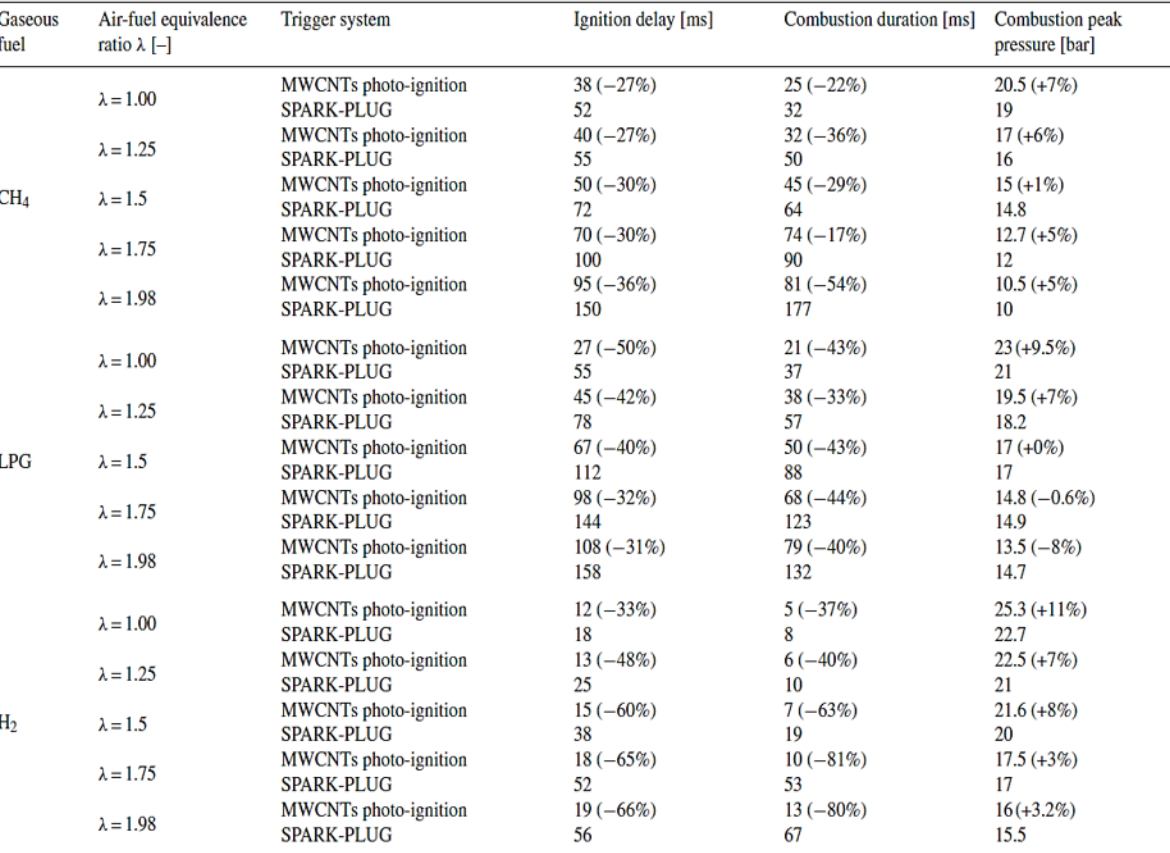
Table 3: Table reporting the improvements of fuels combustion deriving by the use of the nano-particles photo-ignition in place of the traditional spark-plug for CH 4 , LPG and H 2